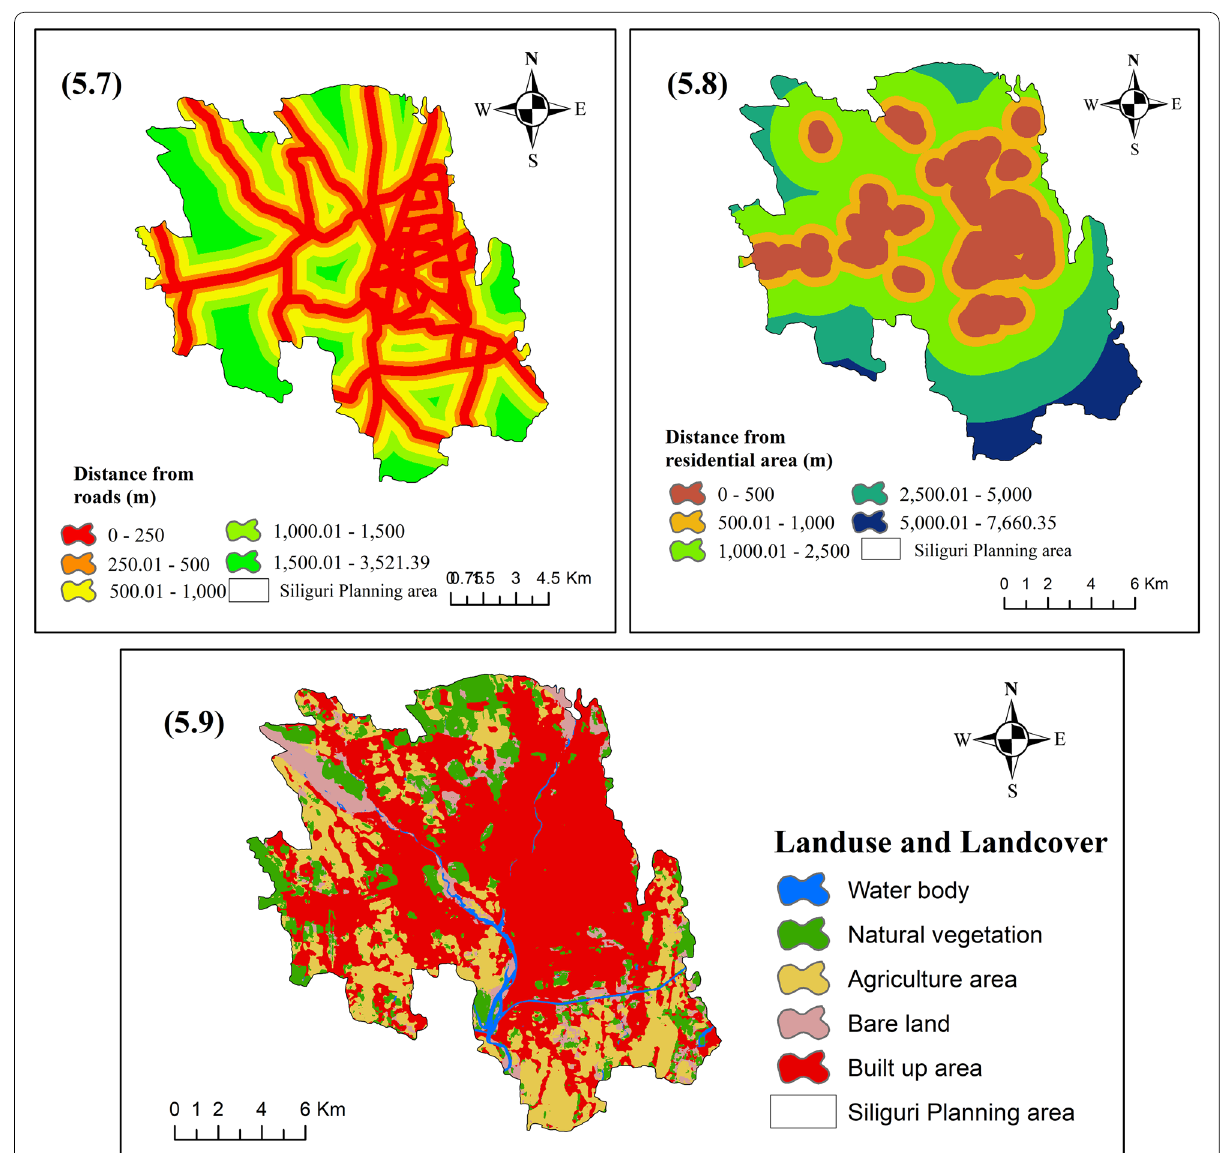
Fig. 5 Raster Layer for Landfill site selection parameter 5.7 Distance from road 5.8 Distance from residential area 5.9 Land use land